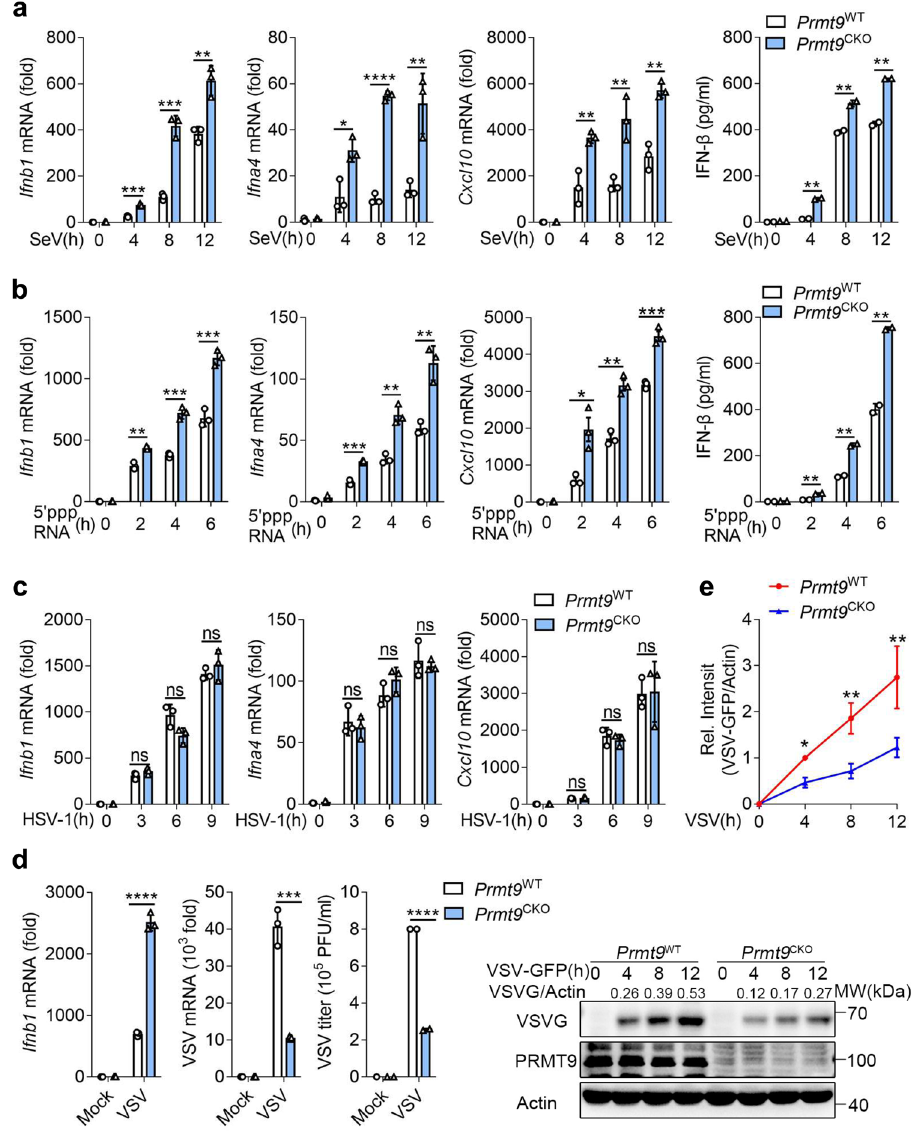
Fig. 2 | PRMT9 de fi ciency in primary peritoneal macrophages enhances RLRs- triggeredIFN- β signaling.a , b ELISAquanti fi cationofIFN- β secretionand( a – c ) qRT-PCR analysis of Ifnb1 , Ifna4 , Cxcl10 mRNA in Prmt9 CKO and Prmt9 WT peri- toneal macrophages infected with a SeV or b stimulated with 5 ′ -pppRNA or infected with c HSV-1 (mean± SD, two-tailed student ’ s t -test Prmt9 CKO vs. Prmt9 WT , for a , Ifnb1 : *** p =0.0002, *** p = 0.0004, ** p =0.0052 in sequence; Ifna4 : * p = 0.0140, **** p < 0.0001, ** p = 0.0088 in sequence; Cxcl10 : ** p = 0.0078,0.0076,0.0017insequence;IFN- β :** p = 0.0012,0.0081,0.0015in sequence, n = 3 independent experiments. For b : Ifnb1 : ** p =0.0011, *** p = 0.0003, *** p = 0.0008 in sequence; Ifna4 : *** p = 0.0002, ** p =0.0020, ** p = 0.0034 in sequence; Cxcl10 : * p = 0.0139, ** p =0.0013, *** p = 0.0008 in sequence; IFN- β : ** p = 0.0034, 0.0024, 0.0024 in sequence, n =3